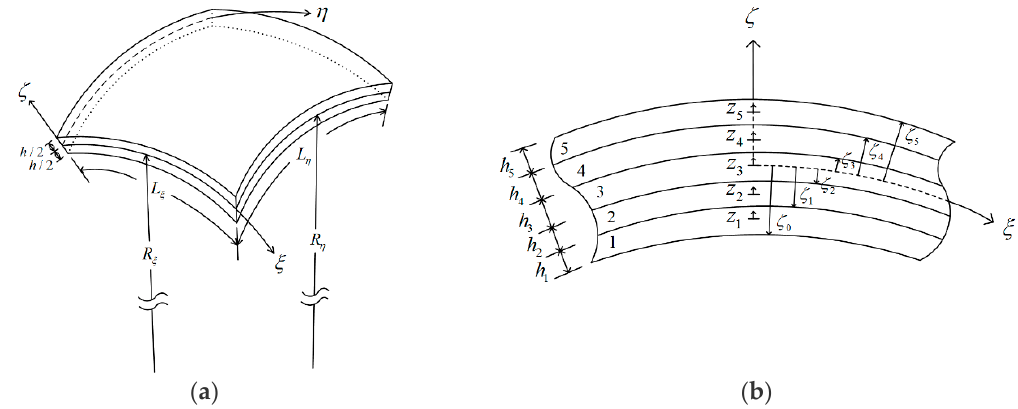
Figure 1. ( a ) The configuration of a functionally graded, doubly curved (FGDC) shell; ( b ) the global and local coordinates of the DC shell.